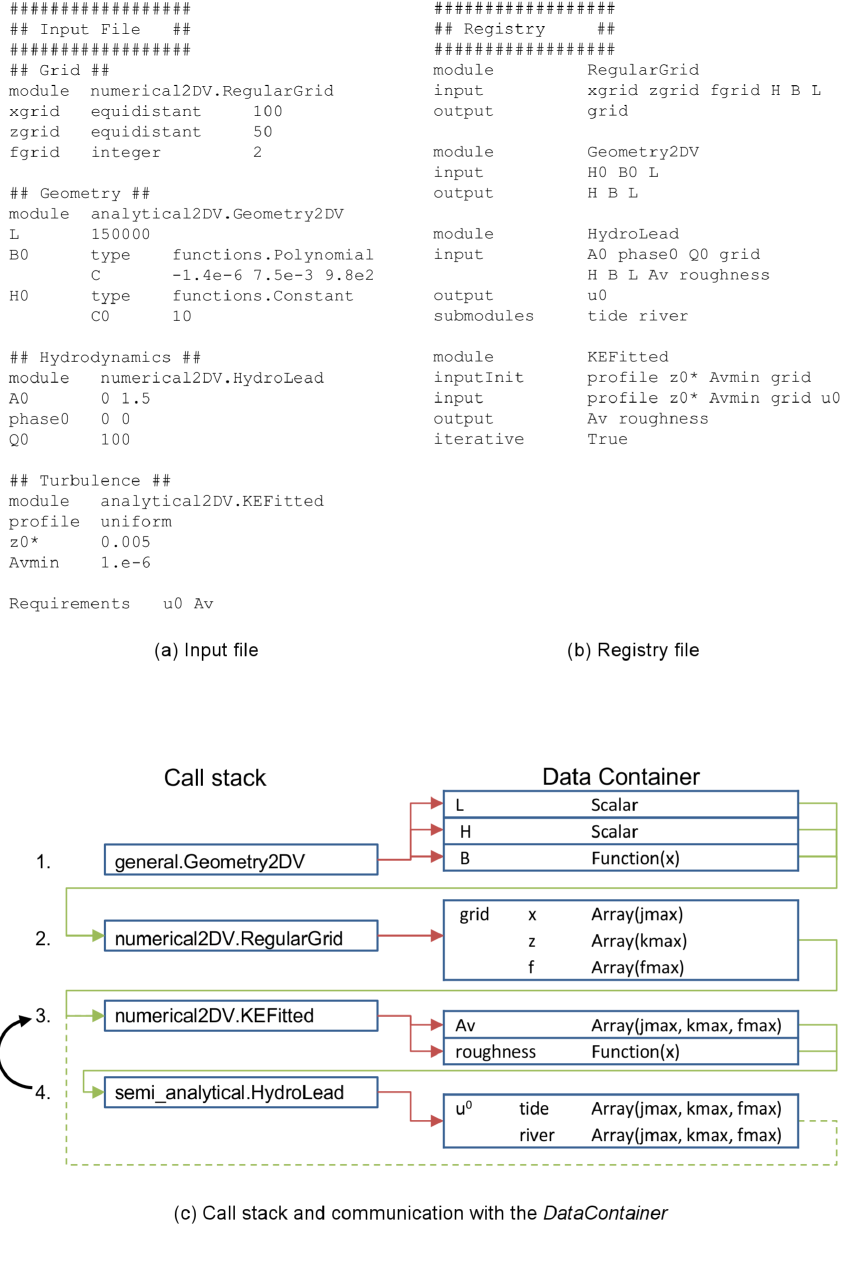
Figure 1. Basic example of input (a) and registry (b) files for a model with four modules. The core uses the input and registry files to make a call stack (c) with the correct order of the modules. The output of each module is stored in the data container to be used as input to other